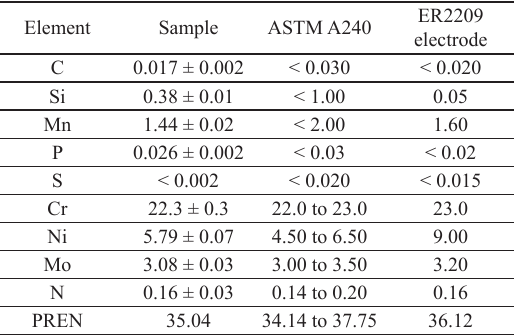
Table 1. Chemical composition of UNS S32205 (wt%) duplex stainless steel plate and requirements established by ASTM A240 30 . Element